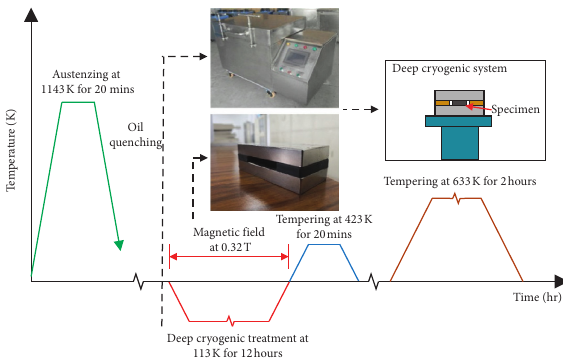
Figure 3: Schematic diagram of process